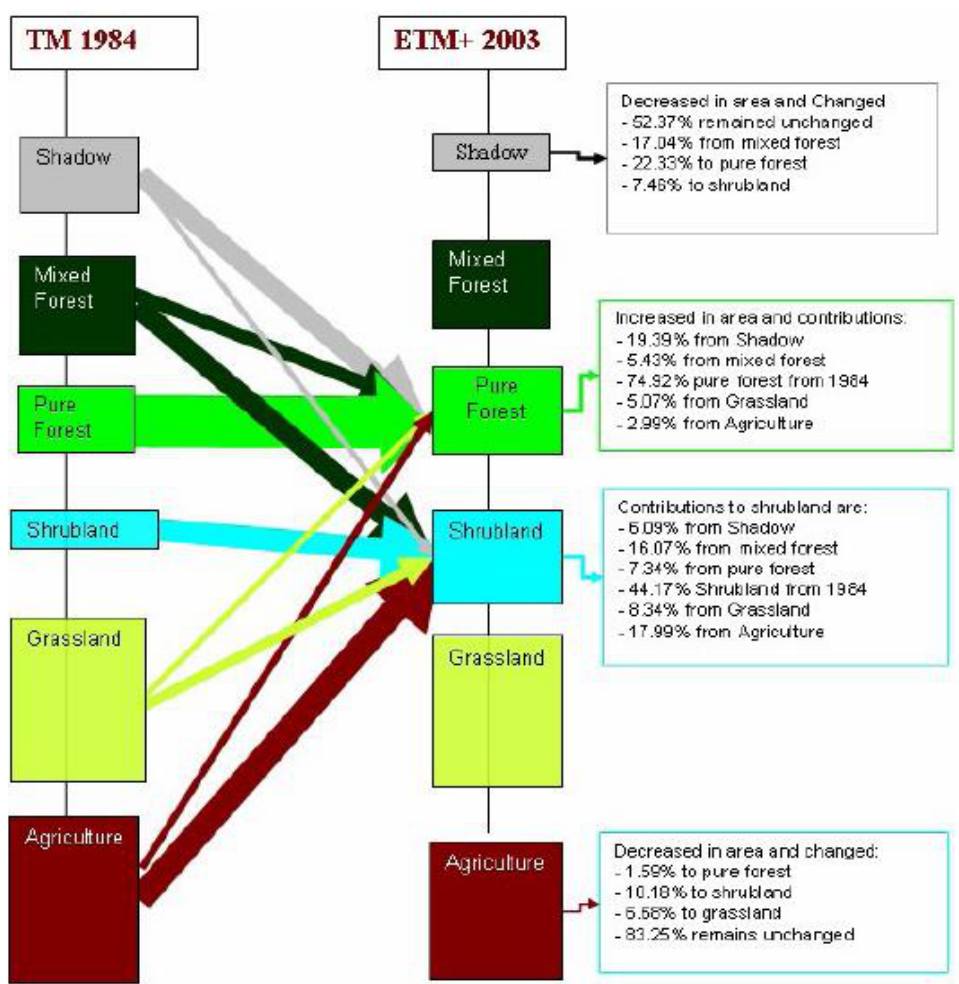
Figure 5. Direction of change of one LC to